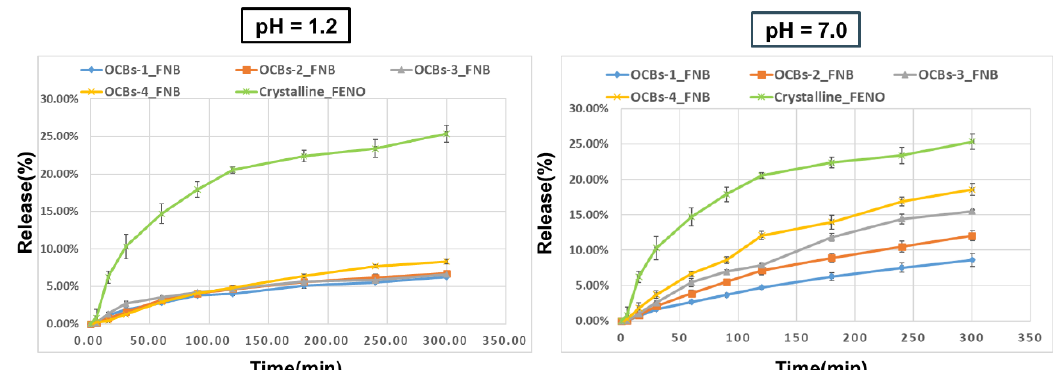
Figure 10. Release profiles of FNB from OCBs at pH = 1.2 (left) and 7.0 (right). The results are presented as mean ± SD, n = 3.